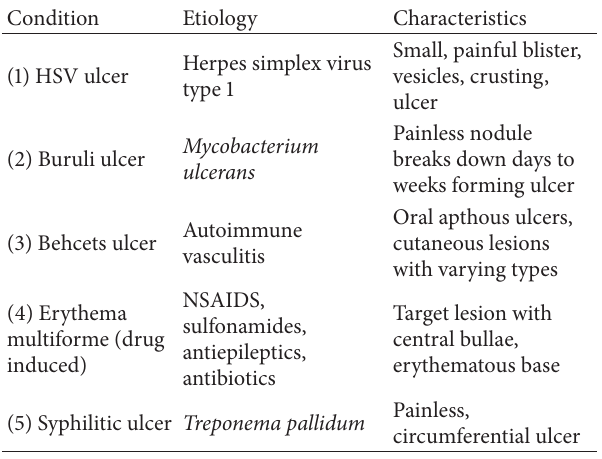
Table 1: Multiple ulcer causing conditions with etiology and char-